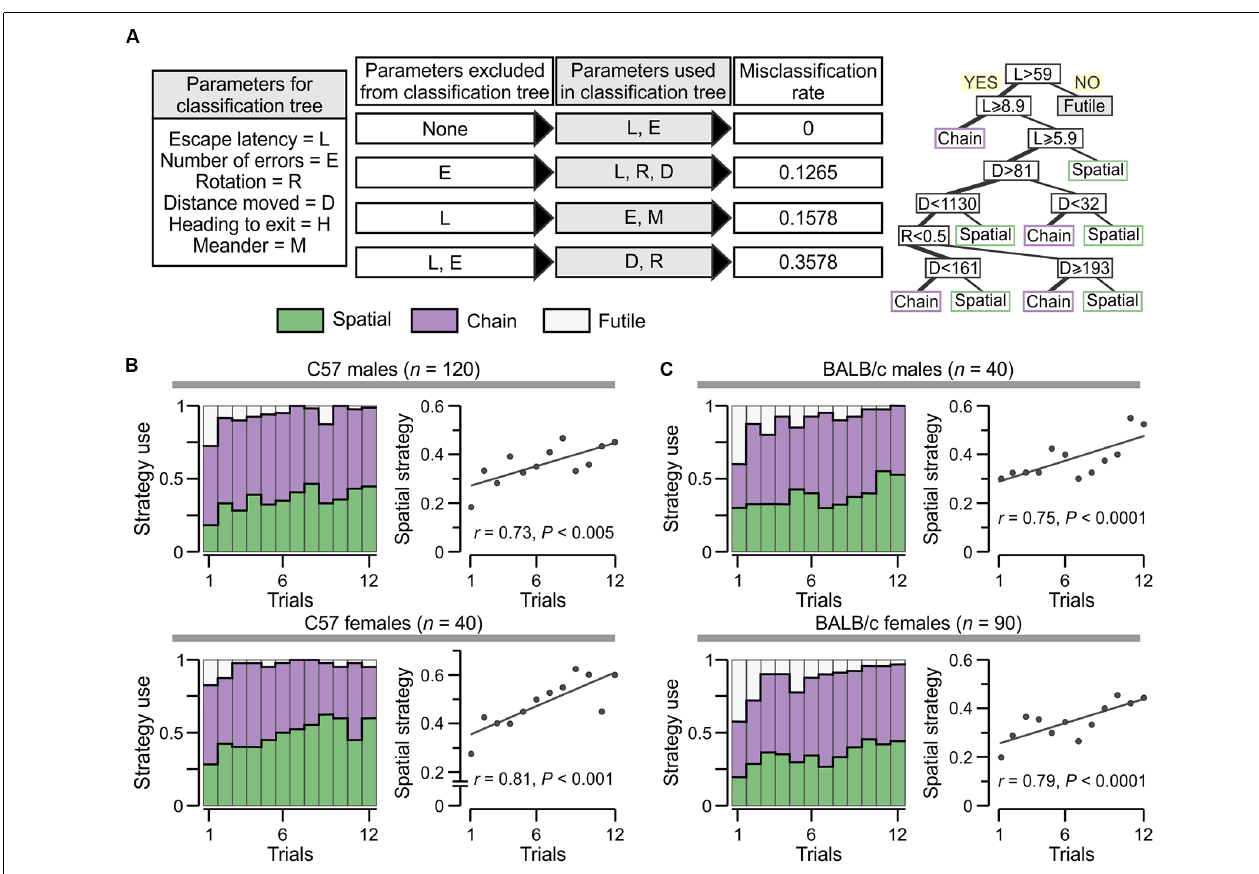
FIGURE 5 | Escape strategy analysis applied to the groups tested in the PPT. (A) Left , parameters used in classification and regression tree (CART) models to determine escape strategy predictors: rotation = number of full rotations done by an animal; distance moved = space (cm) covered; heading to exit = angle (degrees) to which an animal moves toward the true exit; and meander = number of direction changes done by an animal. Middle , Exclusion of certain parameters in the CART models and resulting misclassification rate for each case. As expected, including all parameters gives null misclassification error, whereas excluding escape latency from any CART results in an inability to predict the futile strategy. Right , CART model in which the number of errors is excluded can predict the three strategies with a misclassification score of 12.65%. (B) Escape strategy analysis, with colors as in Panel (A) , applied to C57 males ( top ) and females ( bottom ). The plots (at right ) represent the use of spatial strategy across trials with a linear fit for the data. (C) Escape strategy analysis of BALB/c males ( top ) and females ( bottom ). Scatterplots (at right ) for the use of spatial strategy across trials with a linear fit for the